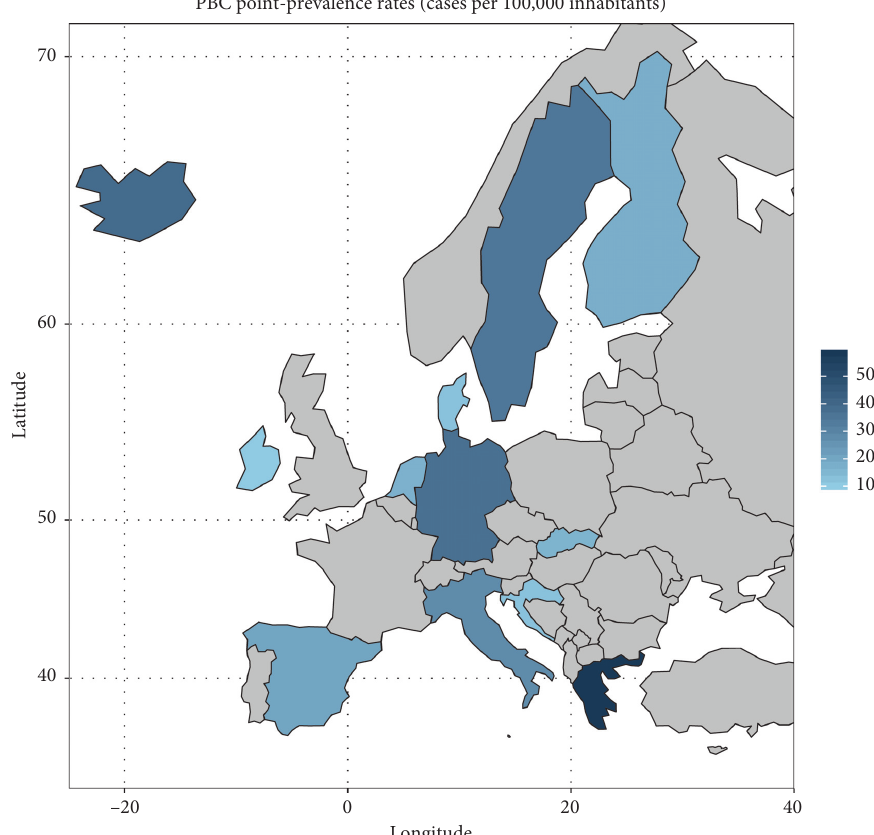
Figure 2: Choropleth map of PBC point-prevalence rates in Europe.